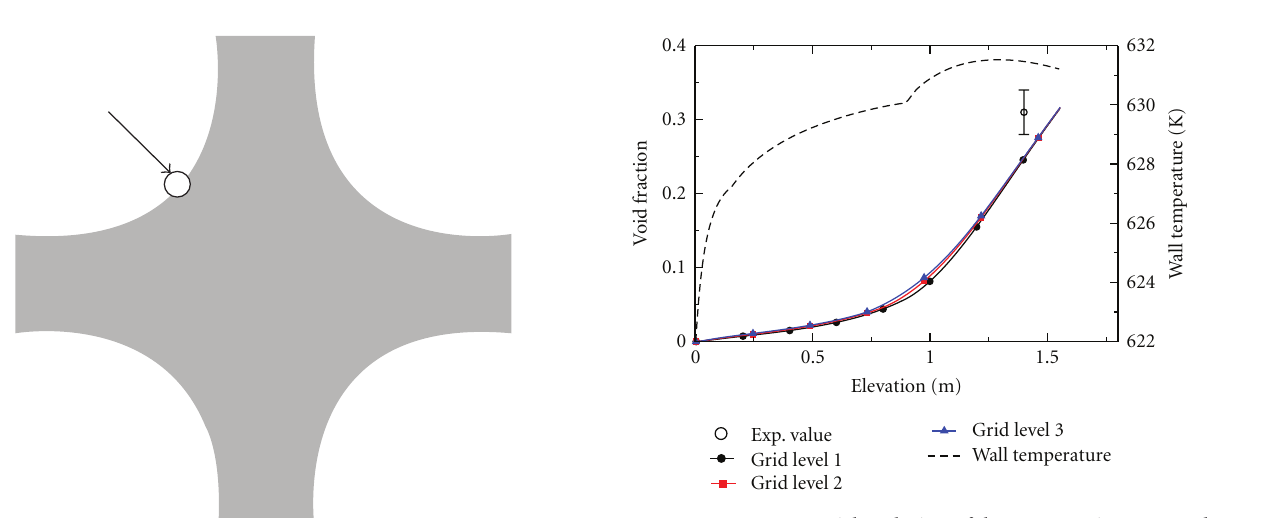
Figure 6: Run 1.2223. Axial evolution of the cross-section averaged void fraction for the 3 grid levels.